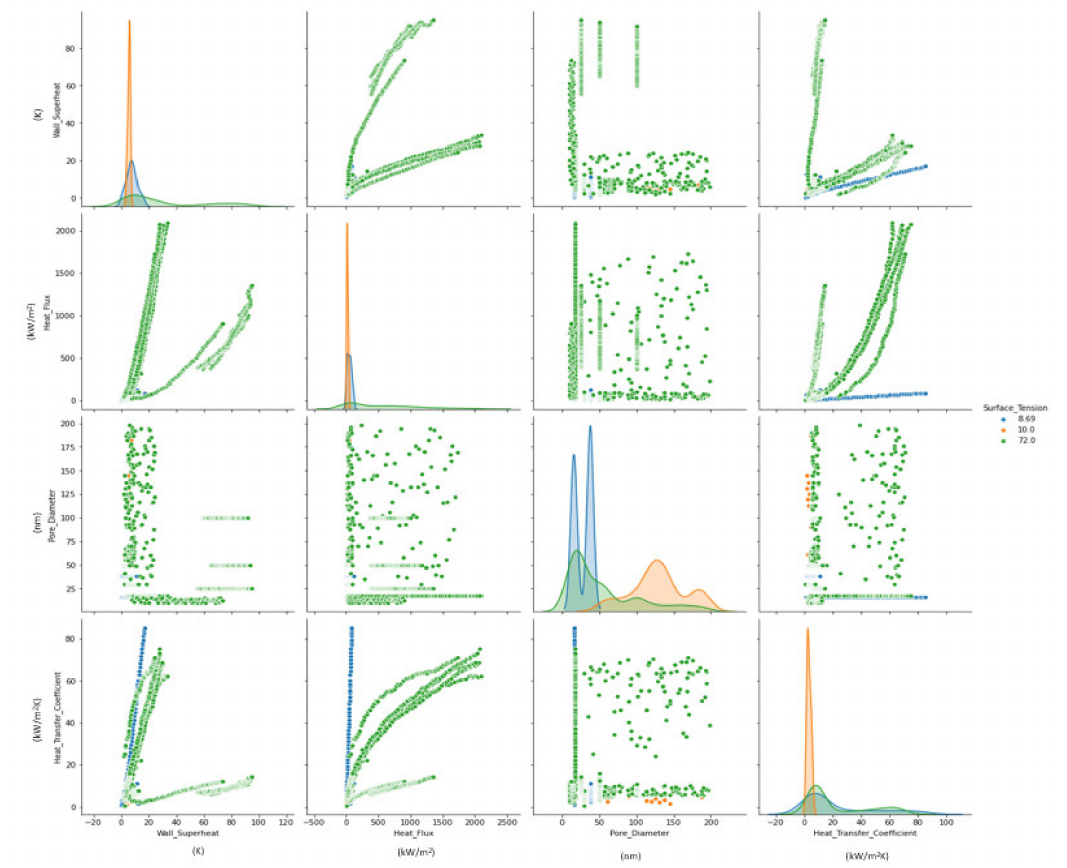
Figure 3. Experimental data distribution of various